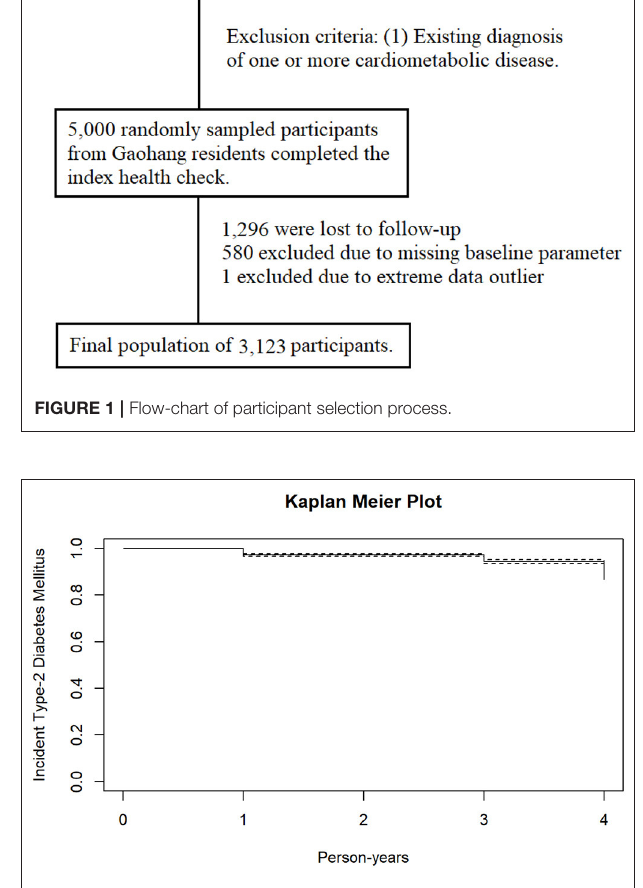
FIGURE 2 | Kaplan meier plot for incident type-2 diabetes